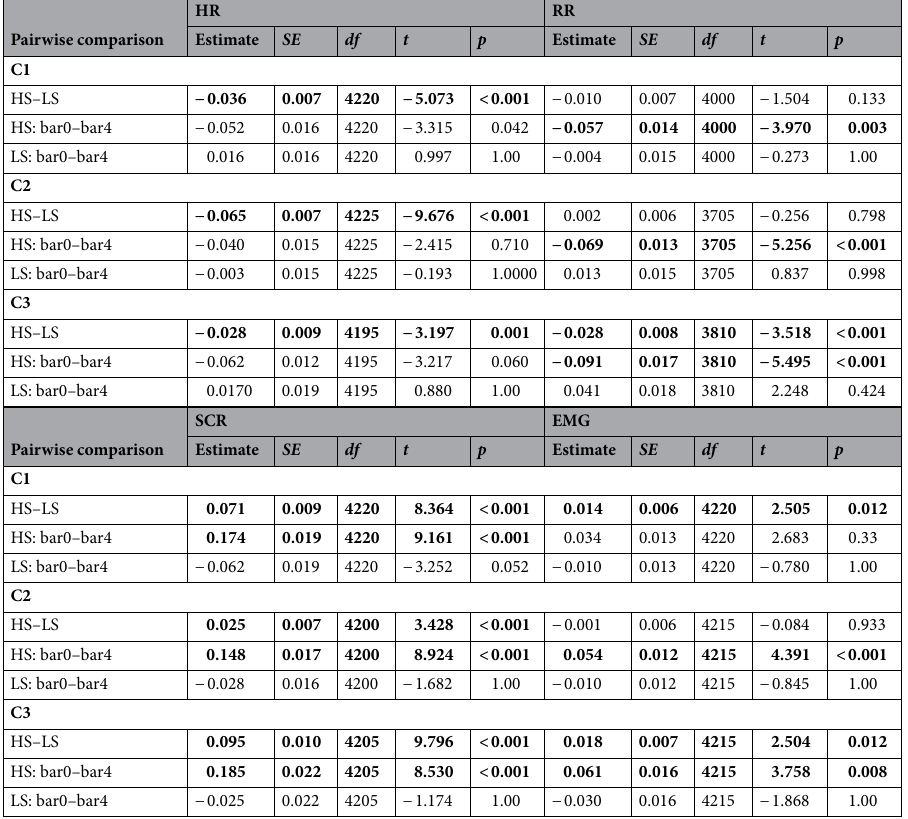
Table 2. Pairwise comparisons of linear models comparing physiology in 5 bar windows for Synchrony (HS/ LS) across correlation windows in terms of Bar (0–4). HS–LS denotes the overall difference between HS and LS windows. Bar0–bar4 denotes the difference between the beginning and the end of the window separately in HS and LS windows. Contrasts (Bonferroni adjusted) were calculated with emmeans package in R. Values highlighted in bold are statistically significant after Bonferroni corrections for multiple